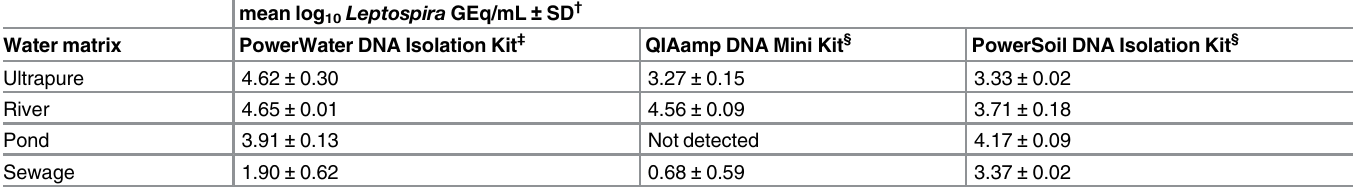
† Data represent the mean results obtained from three independent experiments. Statistical analysis revealed that the difference in DNA extraction ef fi ciency upon comparison of the three kits tested was signi fi cant and was observed for all the four water matrices ( P < 0.0001). ‡ DNA was extracted from 40 mL aliquots, without a centrifugation step.